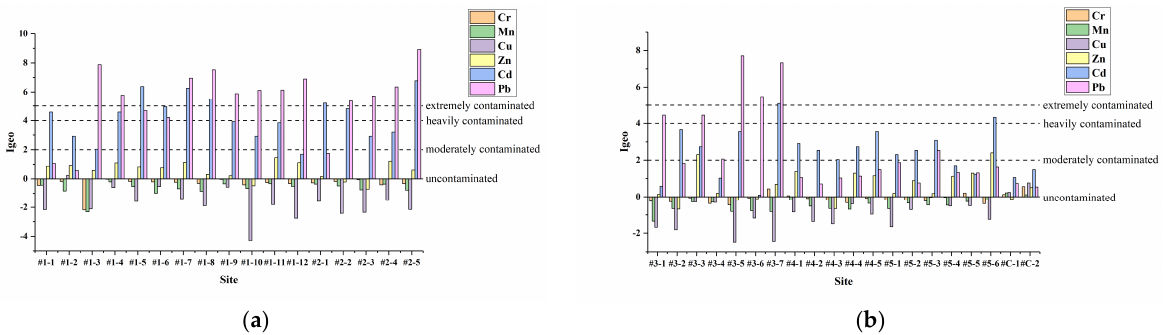
Figure 5. I geo statistics of surface soil HMs at each sample site, ( a ) #1–1 to #2–5; ( b ) #3–1 to #C–2.